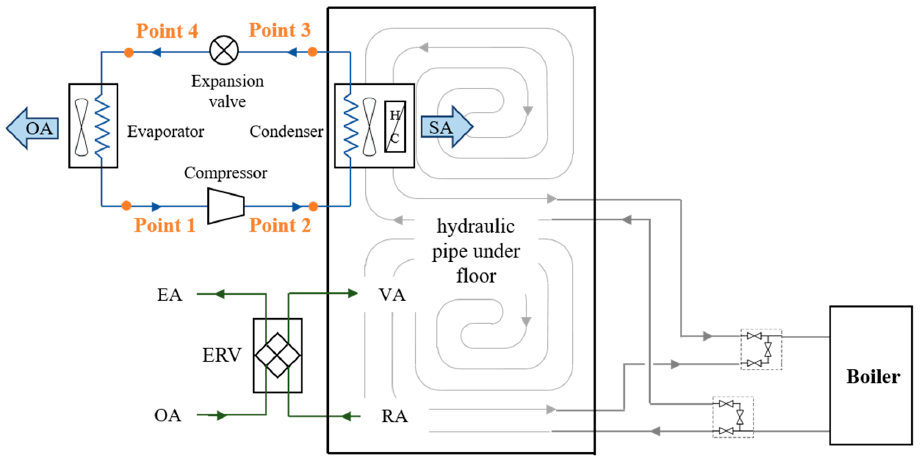
Figure 1. Schematic of the combined system. ERV: enthalpy recovery ventilator.